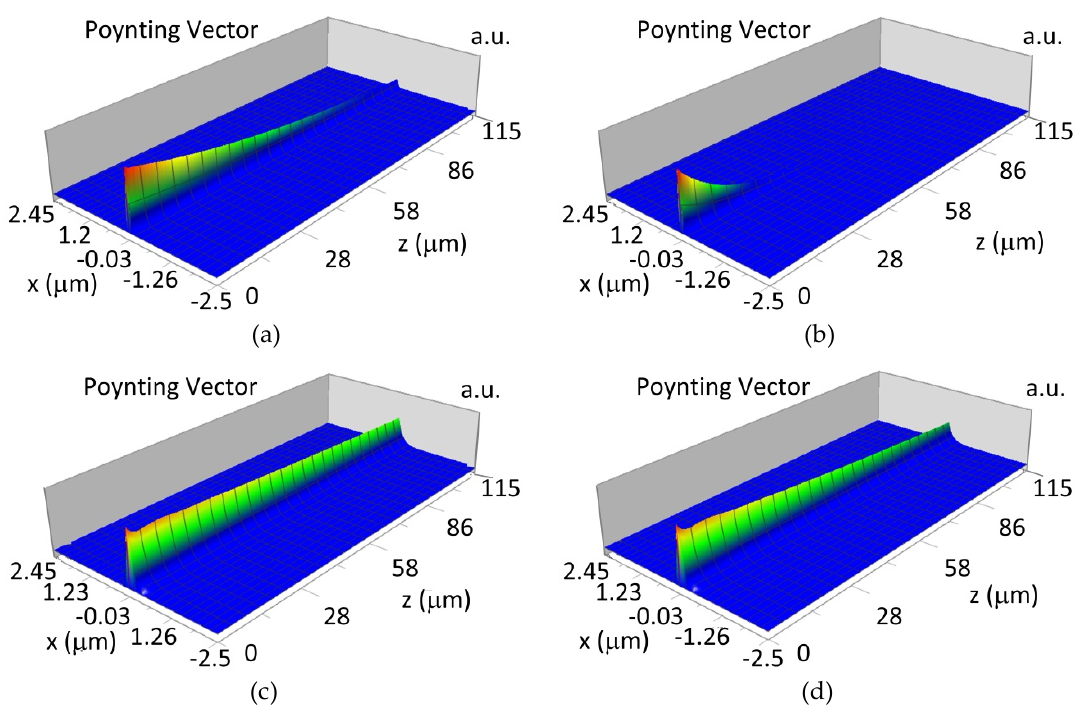
(d) Figure 12. Propagation light in single-mode waveguide structure for TM00, d w = 85 nm (Poynting vector): ( a ) λ = 436 nm, Hb O2 , ( b ) λ = 436 nm, Hb, ( c ) λ = 560 nm, Hb O2 , ( d ) λ = 560 nm, Hb. (a)